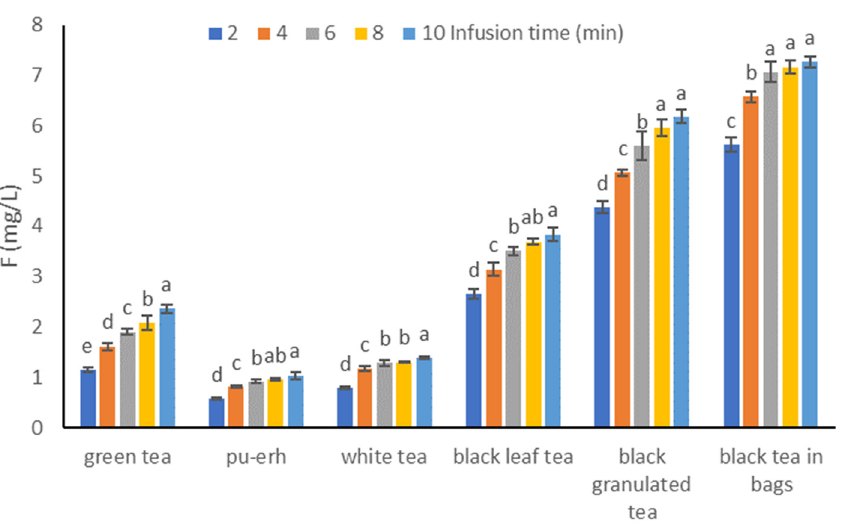
Figure 2. Mean and SD fluoride concentration (mg/L) in the tea infusions for 2, 4, 6, 8, and 10 min infusions. Different letters (a, b, c, etc.) show a significant difference with p < 0.05. The differences relate to each group of tea separately.